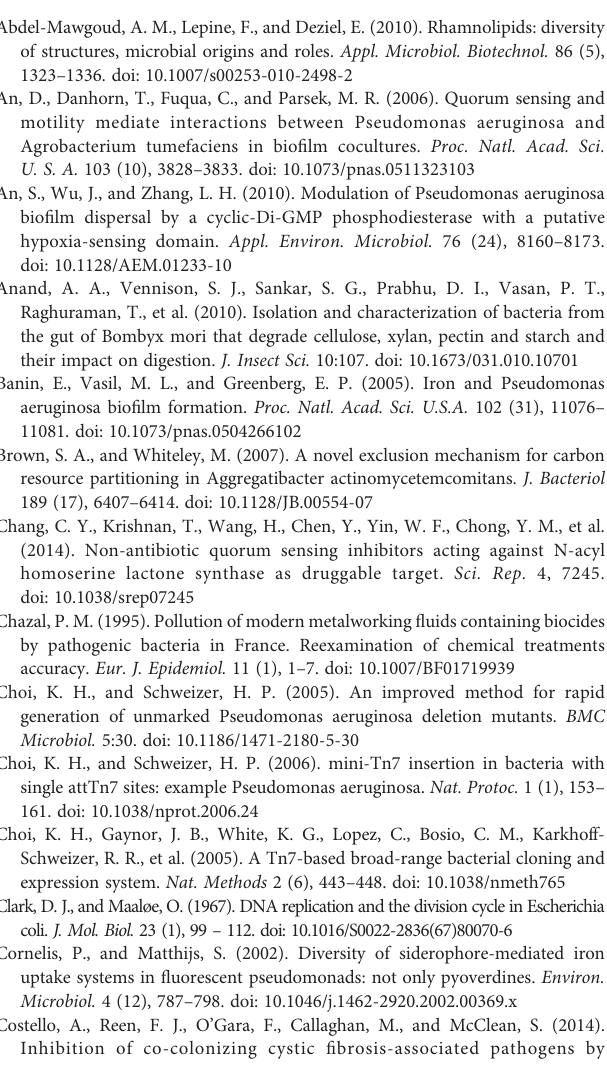
fold change of wild type]. Data shown are average of three independent biological replicates. Supplementary Figure 6 | Pseudomonas aeruginosa mutants are not affected in competition with K. pneumoniae . K. pneumoniae was spotted on a lawn of P. aeruginosa wild type, QS mutants or complemented strains on LB agar plate. This panel shows the plate phenotype on day1 and day2. Supplementary Figure 7 | Pseudomonas aeruginosa QS target mutants are not affected in competition with P. protegens . P. protegens was spotted on a lawn of P. aeruginosa wild type or QS target mutants on LB agar plate. This panel shows the plate phenotype on day1 and day2. Supplementary Figure 8 | Proportions of the P. aeruginosa monospecies bio fi lm.The biovolume per unit area in the monospecies bio fi lm containing eitherthe P. aeruginosa wild type or the QS mutants ( lasIrhlI or lasrRrhlR ) after 3 d of cultivation. Bar charts depict the biovolume per unit area of P. aeruginosa wild type or QS mutant monospecies bio fi lm. The values were derived by cultivating bio fi lms under fl ow cell conditions followed by quantitative image analysis of two independent biological